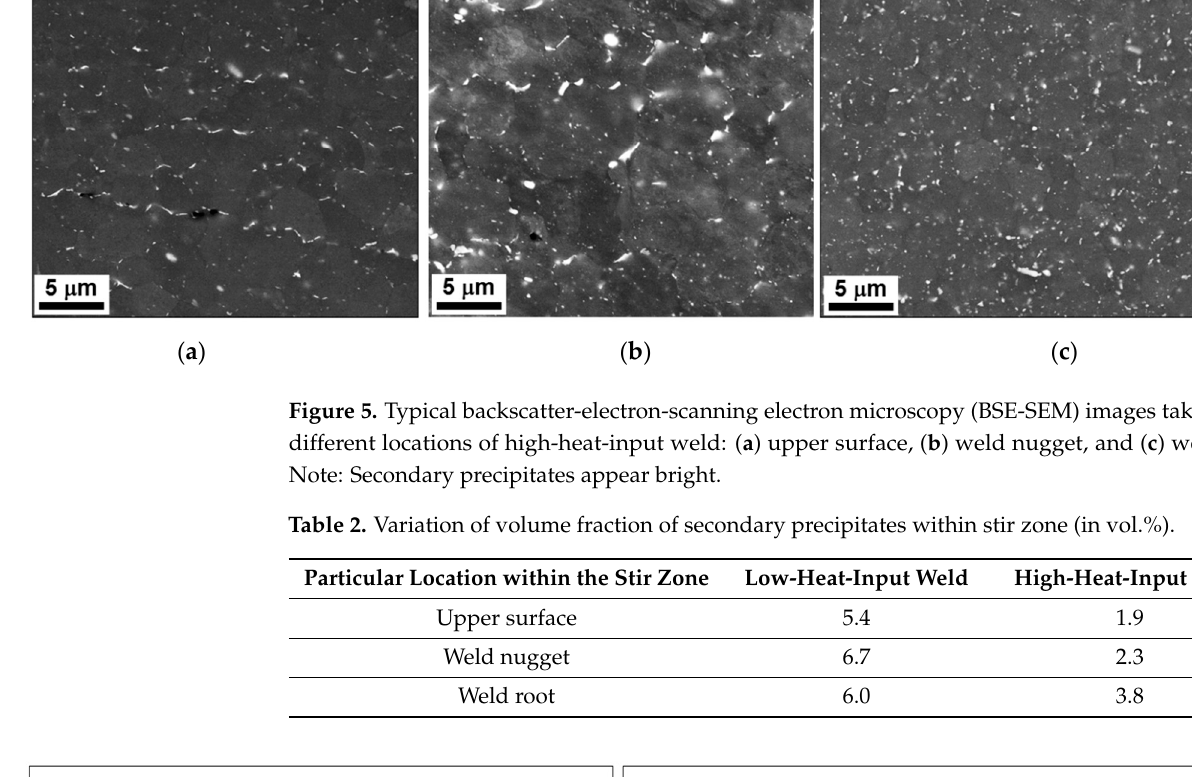
Figure 4. Typical backscatter-electron-scanning electron microscopy (BSE-SEM) images taken from different locations of low-heat-input weld: ( a ) upper surface, ( b ) weld nugget, and ( c ) weld root. Note: Secondary precipitates appear bright.